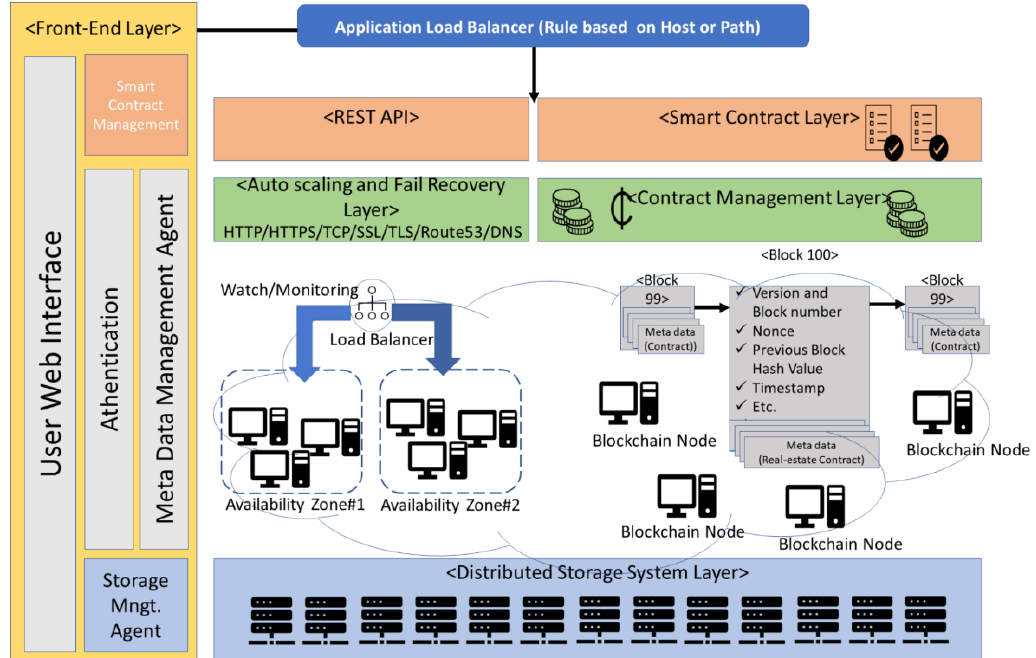
Figure 3. Server and network configuration.